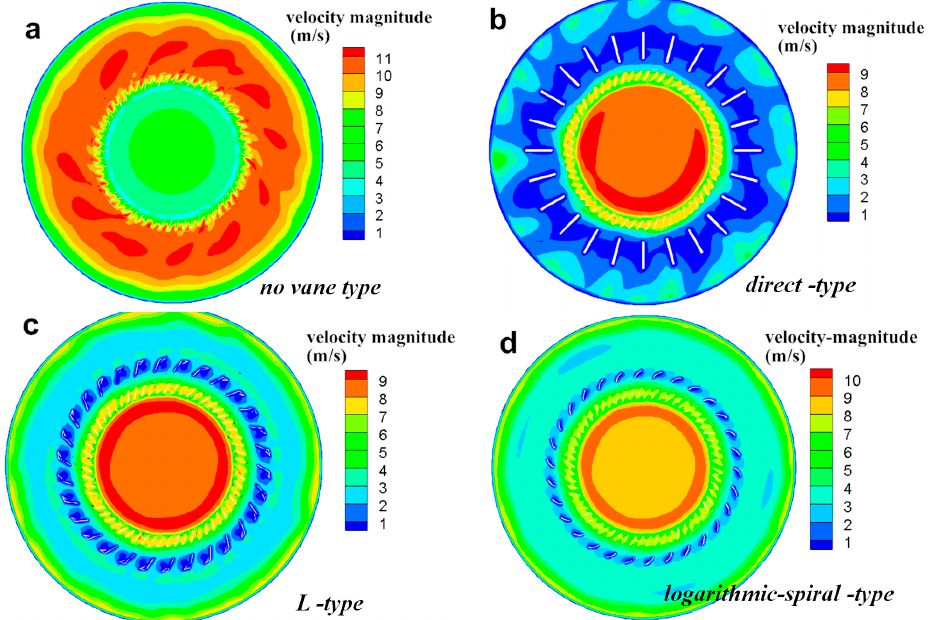
Figure 10. Comparison of the velocity magnitude distribution of the rotor cage by four different guide vanes in (Z = 0 m) section, ( a ) no vane type; ( b ) direct-type; ( c ) L-type; ( d ) logarithmic-spiral-type.